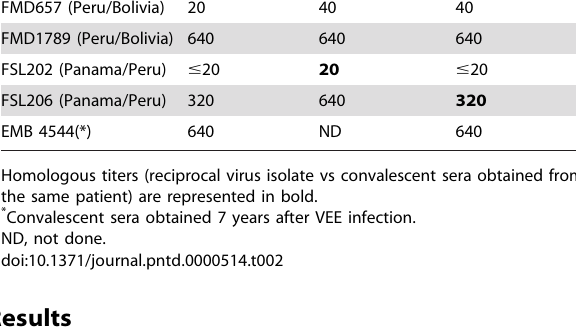
Homologous titers (reciprocal virus isolate vs convalescent sera obtained from the same patient) are represented in bold. * Convalescent sera obtained 7 years after VEE infection. ND, not